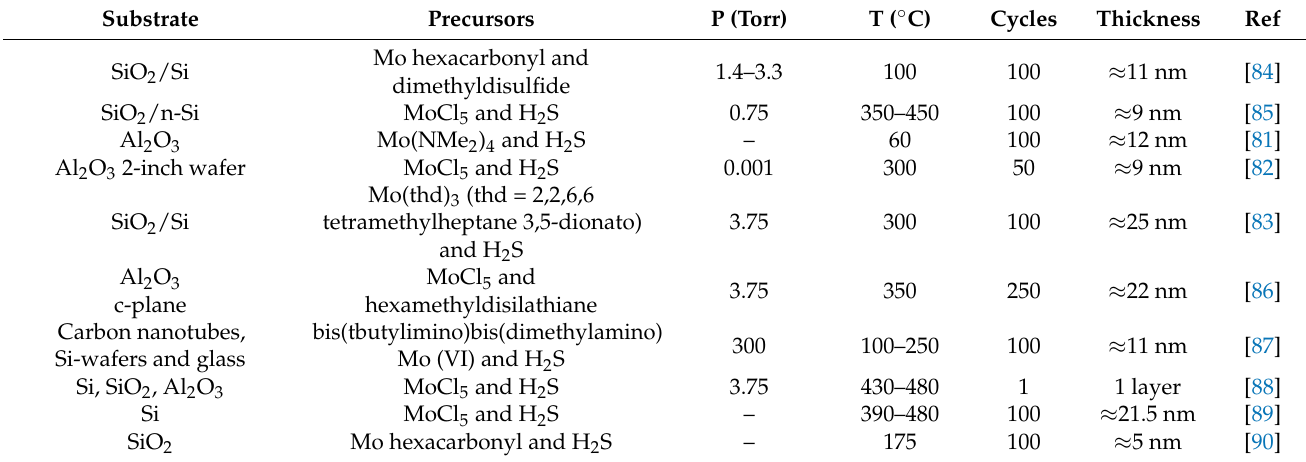
Table 4. Summary of the ALD deposition conditions and achieved MoS 2 film